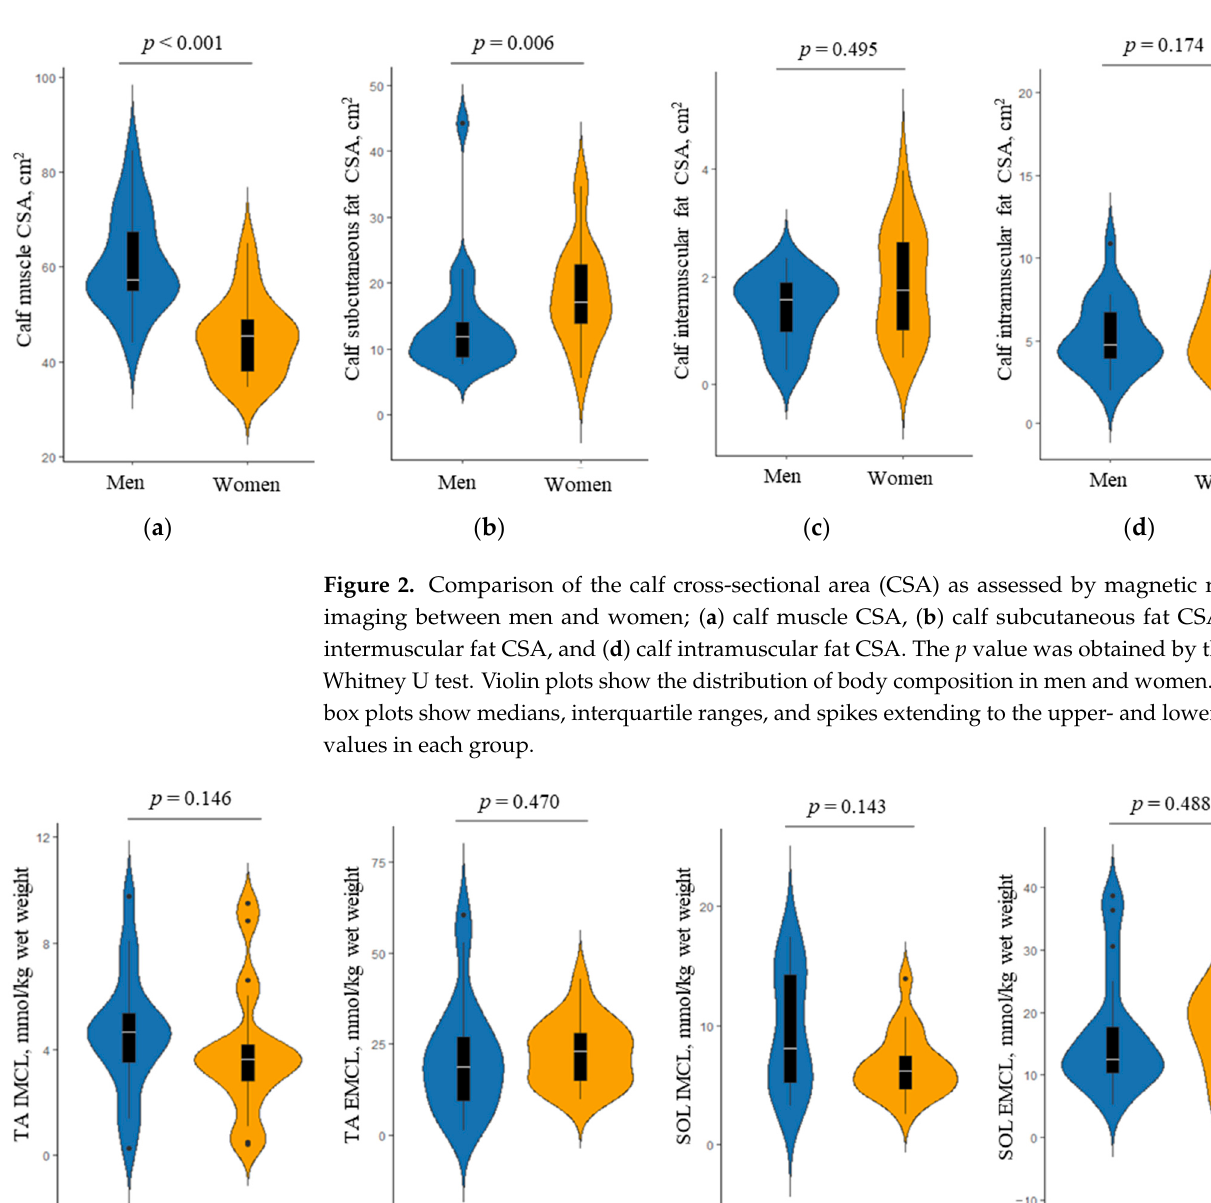
Figure 3. Comparison of the amounts of intramyocellular lipid (IMCL) and extramyocellular lipid (EMCL) in the tibialis anterior (TA) and soleus (SOL), as assessed by proton magnetic resonance spectroscopy, between men and women; ( a ) TA IMCL, ( b ) TA EMCL, ( c ) SOL IMCL, and ( d ) SOL EMCL. The p value was obtained by the Mann–Whitney U test. Violin plots show the distribution of body composition in men and women. Overlaid box plots show medians, interquartile ranges, and spikes extending to the upper- and lower-adjacent values in each group.